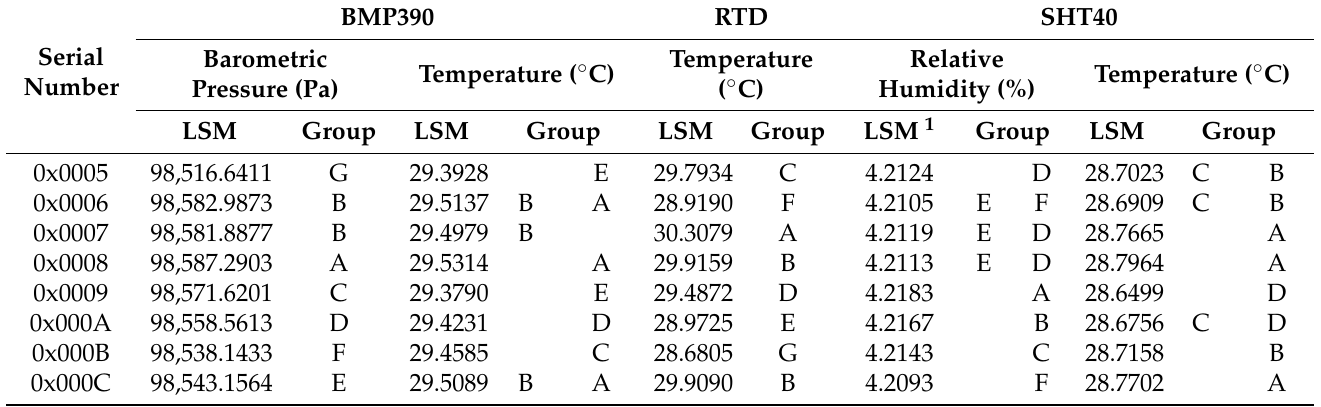
Table 9. Tukey-Kramer grouping for least-squares means (LSM) of PTH probe sensors during calibration run. Within a column, LSMs with the same letter are not statistically